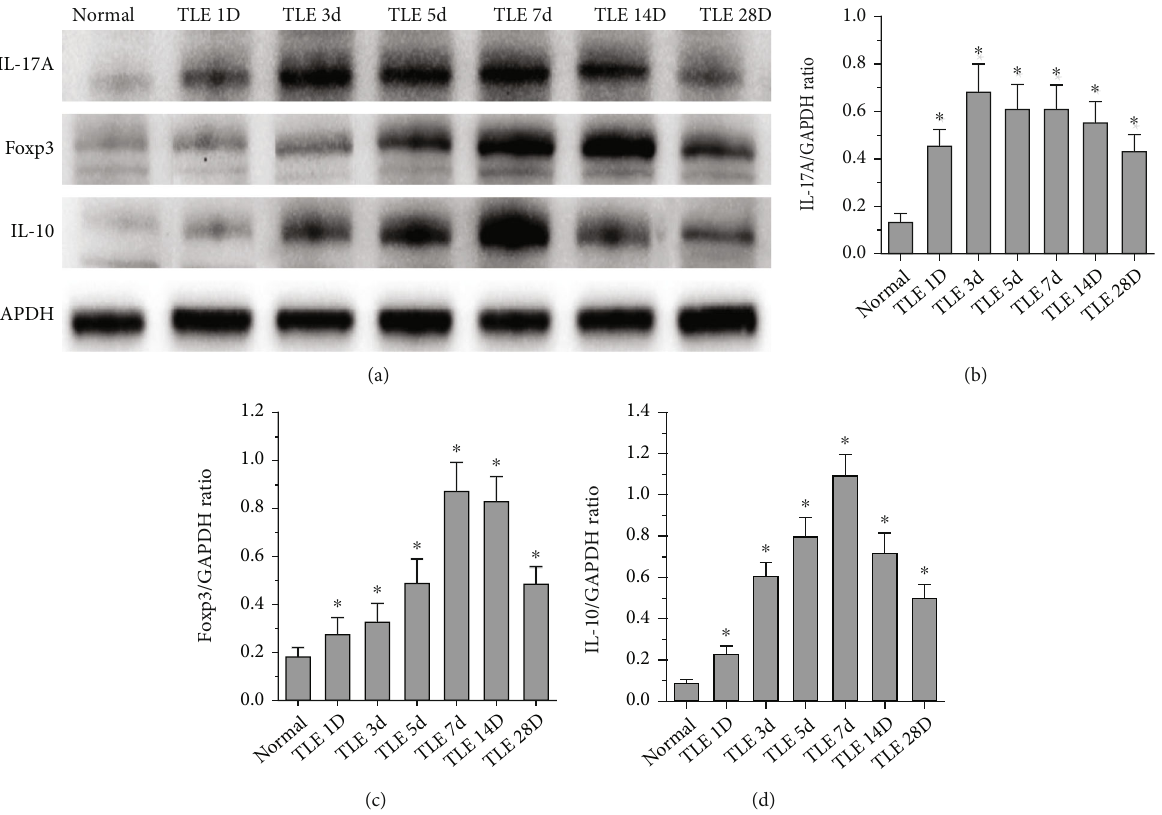
Figure 6: Changes of the expressions of IL-17A, Foxp3, and IL-10 proteins in the pathogenesis and development of epilepsy. (a) Representative Western blotting images of IL-17A, Foxp3, and IL-10 proteins in the hippocampus of the normal group and TLE group at di ff erent times. (b) Densitometric analysis normalized to GAPDH was presented as IL-17A expression. (c) Densitometric analysis normalized to GAPDH was presented as Foxp3 expression. (d) Densitometric analysis normalized to GAPDH was presented as IL-10 expression. The data were represented as mean ± SD . ∗ P < 0 : 05 , vs. the normal